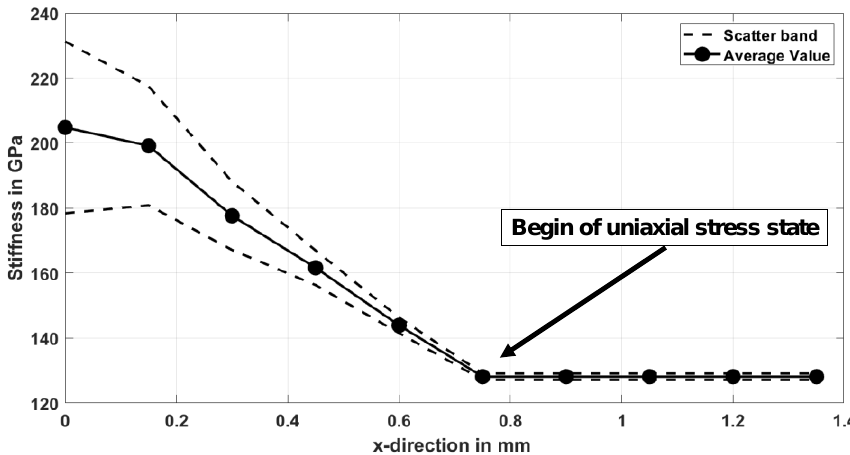
Figure 19. Development of stiffness into the bulk material for the fine-grain textured material.